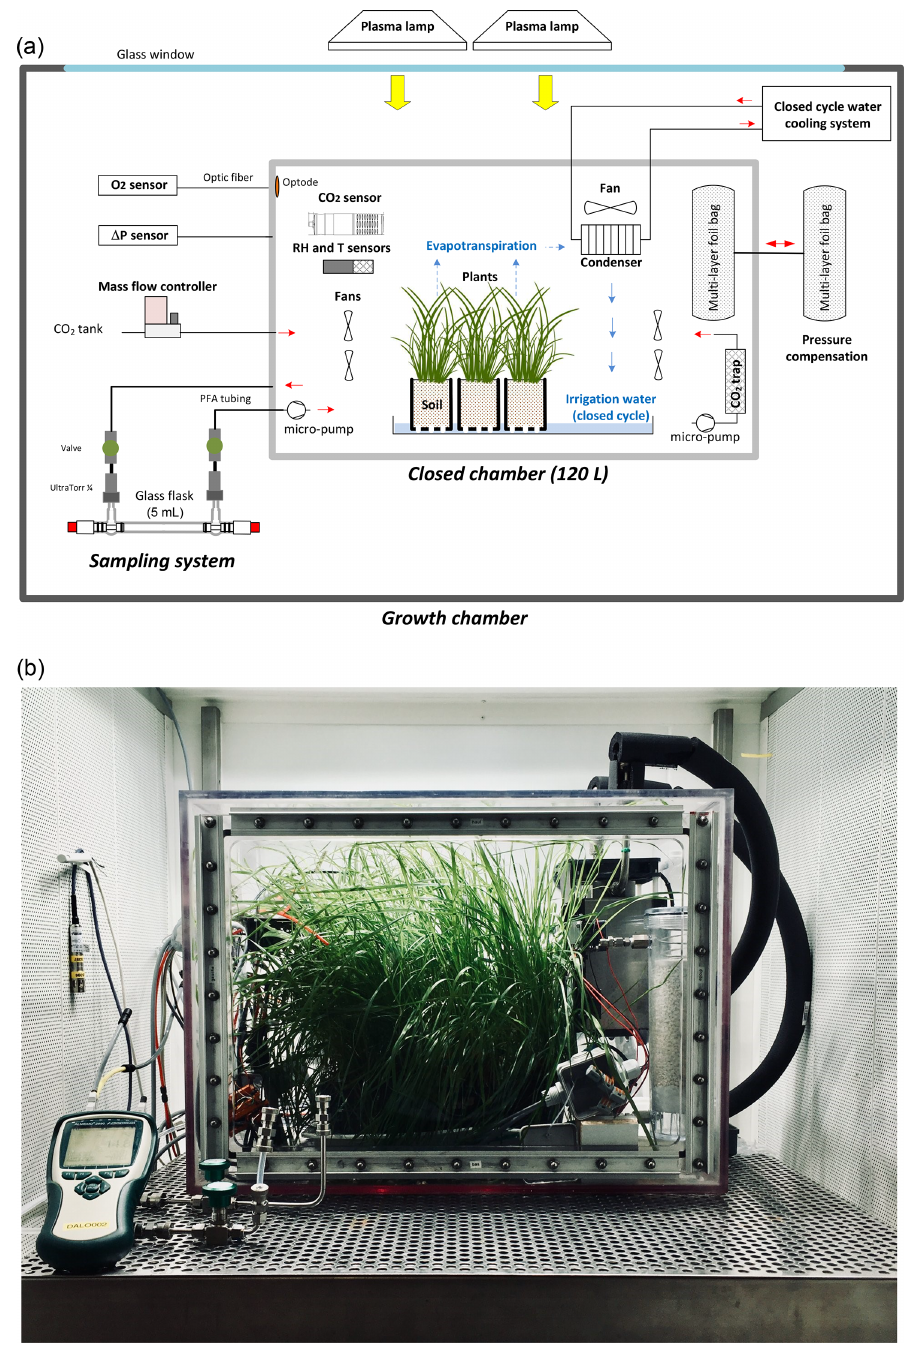
Figure 1. A vegetation–soil–atmosphere analogue of the terrestrial biosphere in a closed chamber. (a) Schematic of the closed chamber set-up used for the terrestrial biosphere model. The 120dm 3 gas tight closed chamber containing a terrestrial biosphere analogue is enclosed in a larger growth chamber from the Ecotron Microcosms platform. Main environmental parameters inside the closed chamber are actively controlled and monitored: temperature ( T ), light intensity, CO 2 , relative humidity (RH), and pressure differential ( (cid:49)P ). The water cycle in the closed chamber is shown in blue. (b) Photograph of the closed chamber used in the experiment with Festuca arundinacea .